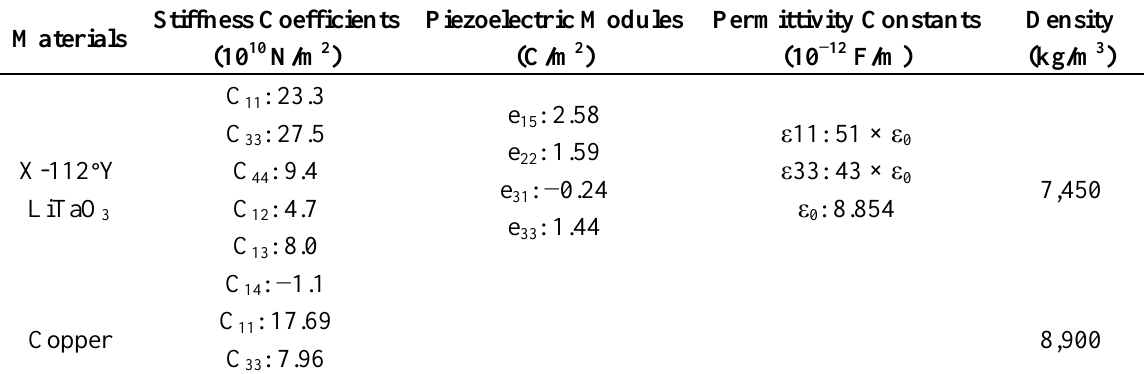
Table 1. The mechanical parameters of the substrate and the metal layers [11,12].